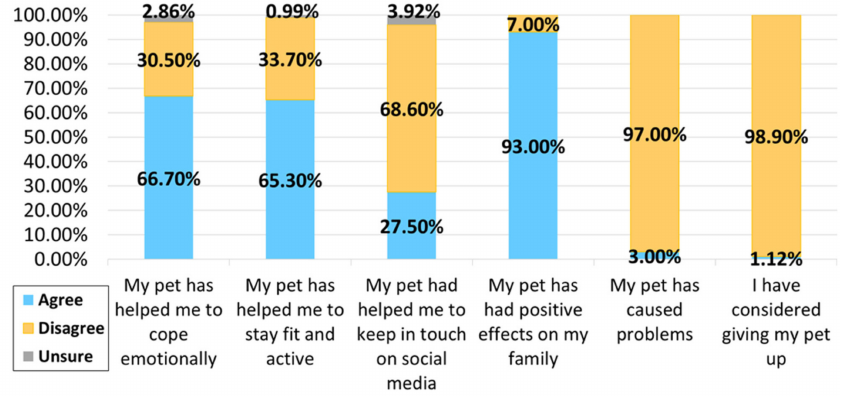
Figure 4. Perceptions of pet-owning people without MS during